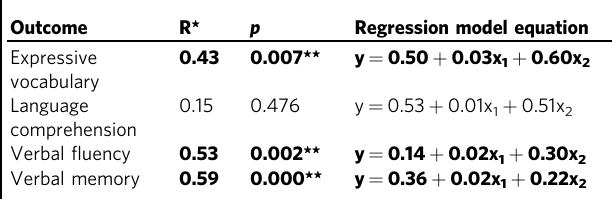
Table 2 LIs of the STS depths predict later language